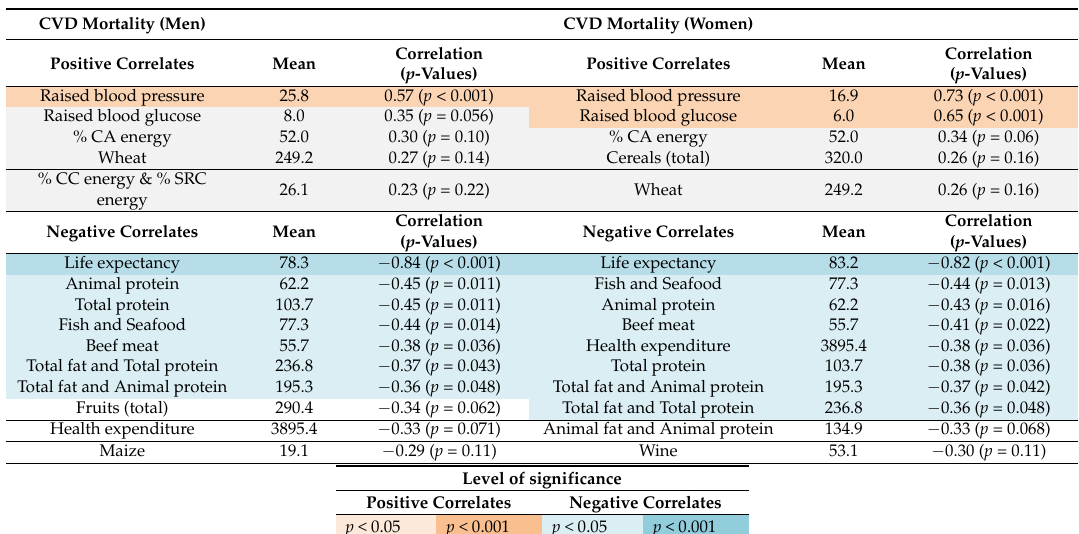
Table 7. Relationship between men’s raised blood pressure, CVD mortality and the examined variables, including smoking prevalence (115 countries). Raised Blood Pressure Table 9. Relationship between CVD mortality and independent variables in 31 countries with health expenditure above 2000 USD per capita.